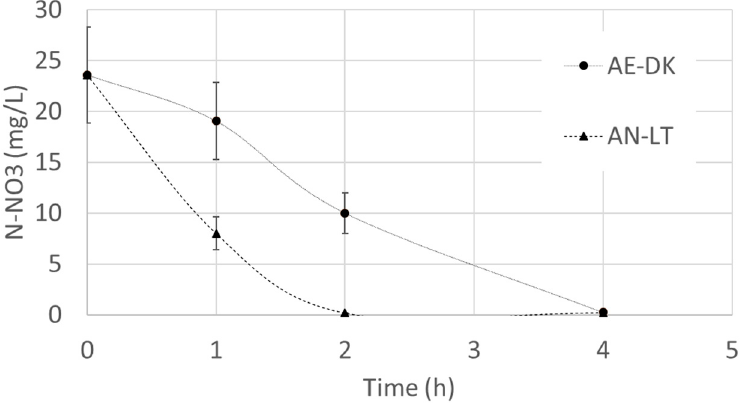
Figure 3. Nitrate depletion with time during NUR test for R. capsulatus grown in aerobic-dark (AE-DK) and anaerobic-light (AN-LT) conditions.